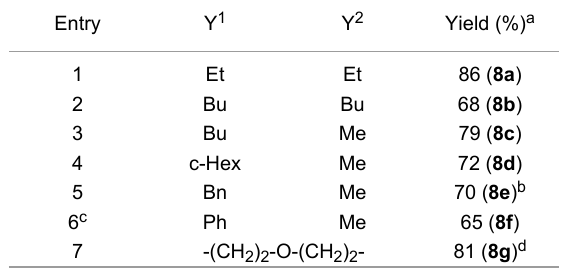
Table 5: Synthesis of (dialkylaminomethylene)bisphosphonates 8a–g